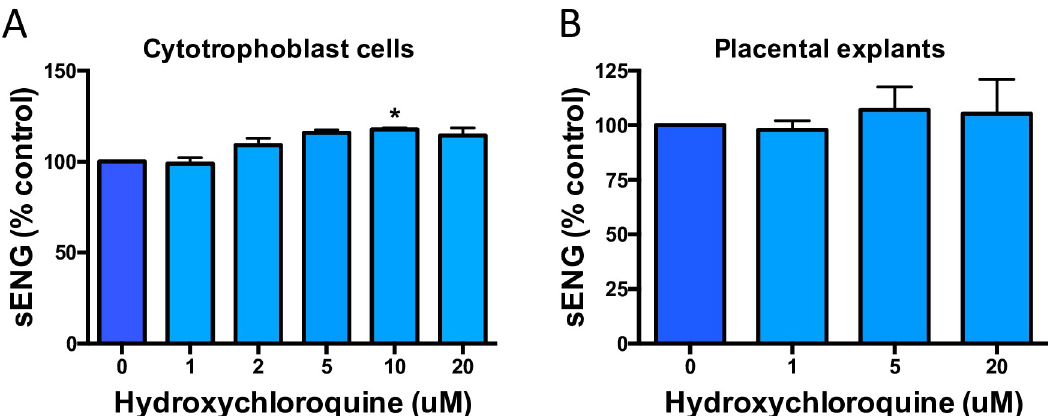
Fig 2. The effects of hydroxychloroquine on sENG in cytotrophoblasts and explants of preeclamptic placentas. Increasing doses of hydroxychloroquine demonstrated a modest increase the secretion of sENG in cytotrophoblasts (a) with a similar but insignificant trend observed in explants (b), compared to untreated controls. Data are means ± SEM of minimum three independent experiments. � p < 0.05, (Friedman